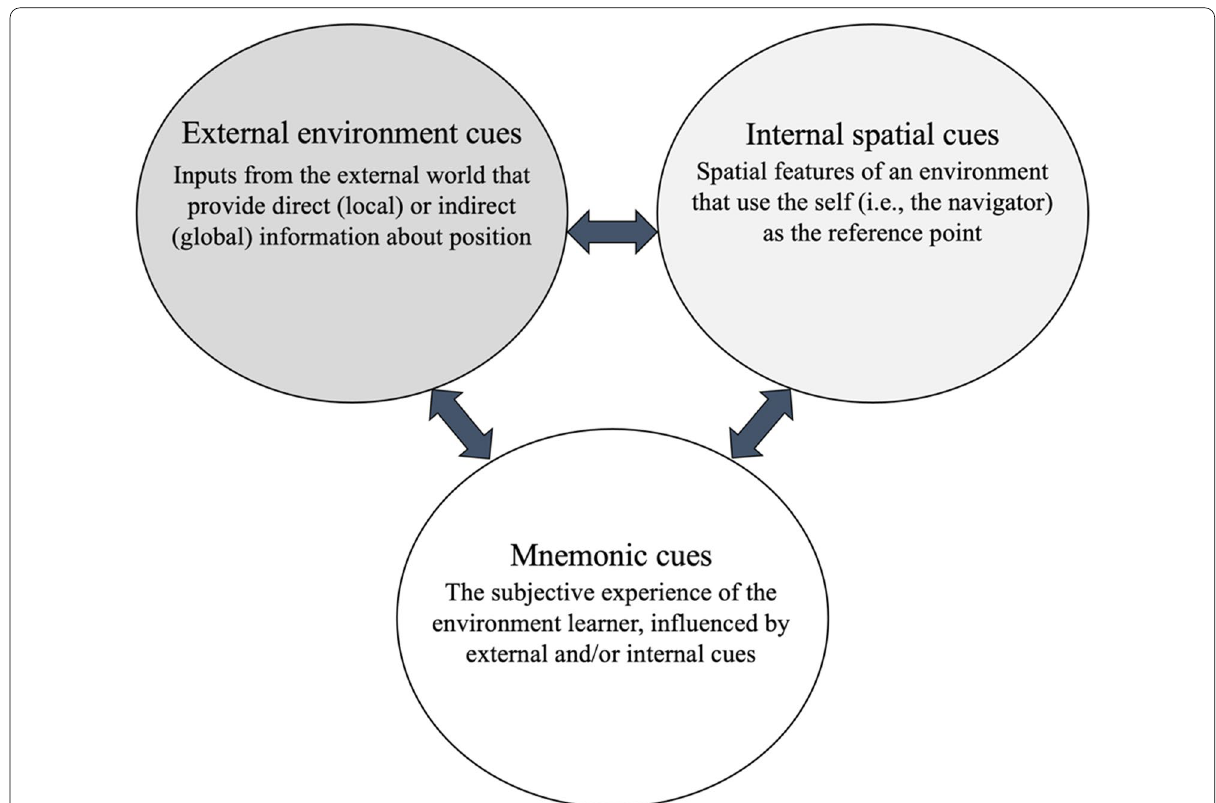
Fig. 1 Cue categories and interactions. Monitoring these cues informs how learners metacognitively control the learning